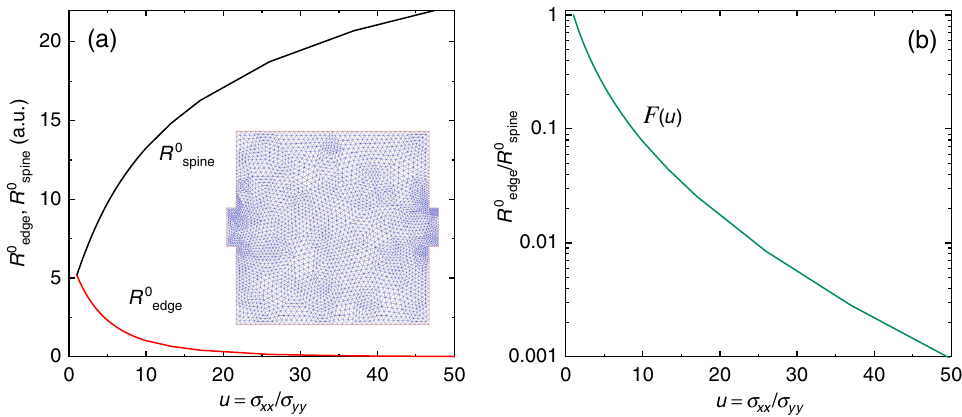
FIG. 3. Procedure to obtain the intrinsic LMR curve R vs B and the intrinsic anisotropy u ¼ ρ yy = ρ xx from measurements of R intr edge and R . Panel (a) plots the calculated resistances R 0 and R 0 vs u with ρ xx ¼ ρ 0 (case 1) [obtained by solving the anisotropic spine edge spine Laplace equation (11)] in a 2D sample (matched to x and y dimensions of the sample). The divergent trends reflect the enhancement of J ð r Þ along the spine and its decrease at the edge. The inset shows the triangulation network generated during the simulation. The stubs on the left and right edges are current contacts. Panel (b) plots the calculated template function F ð u Þ in the semilog scale [Eq. (12)]. Equating the measured ratio G ð B Þ to F ð u Þ , and using Eq. (13), we derive the intrinsic field profiles of R and u (see Fig. 4). intr